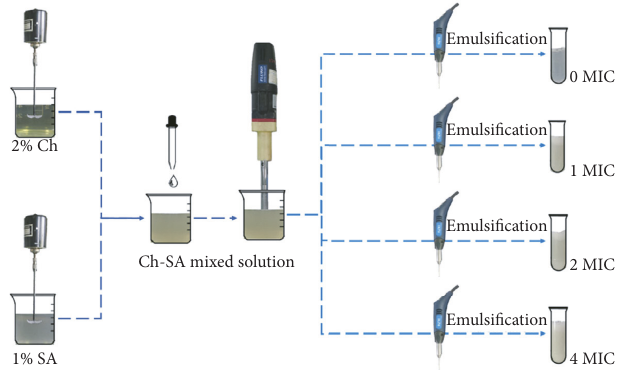
Figure 1: Flow chart of the preparation of Ch-SA stabilized DMY pickering